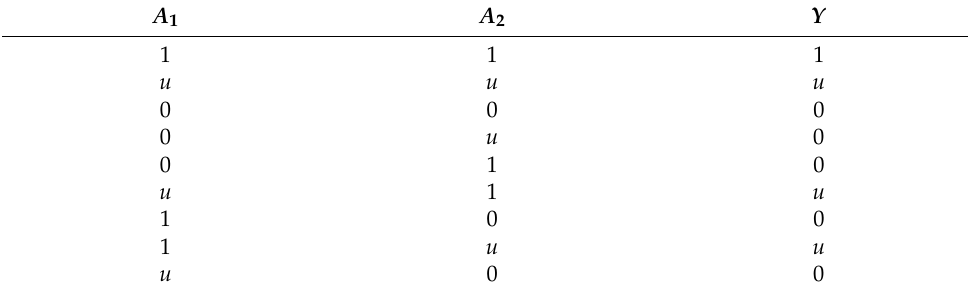
Table 2. Codification example for a Kleene